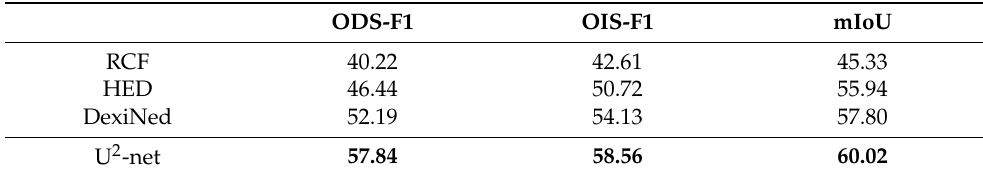
Table 1. Experimental results on the Nanjing dataset with edge detection models.